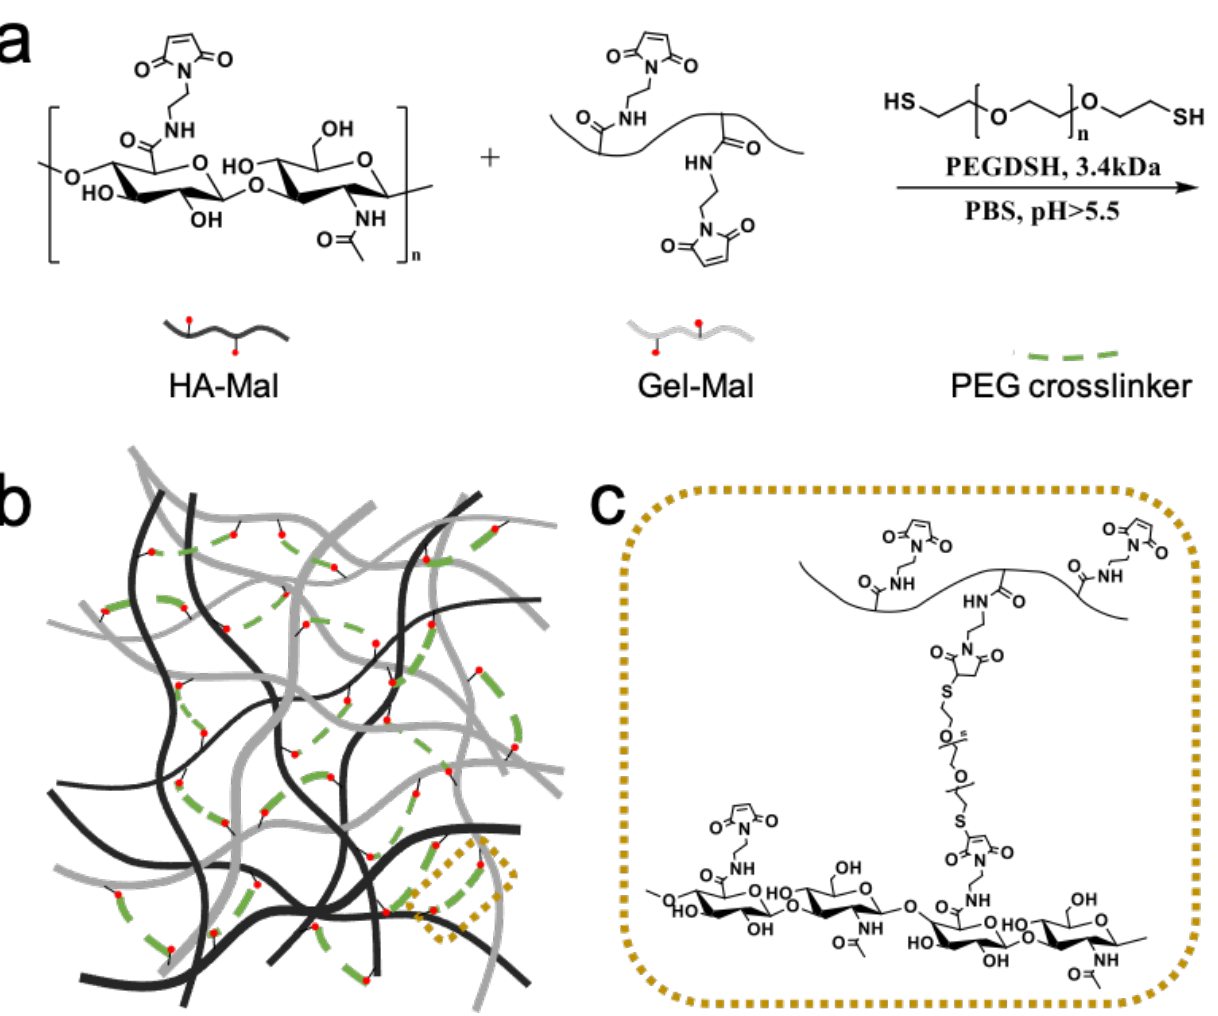
Figure 3. Hydrogel formulation. ( a – c ) Schematic representation of the rapid hydrogel crosslinking reaction with HA-Mal, Gel-Mal, and PEGDSH in PBS. Maleimide groups (red circle) on both HA (black line) and gelatin (gray line) undergo Michael addition reactions with thiols on the PEG crosslinker (dotted green line), resulting in a crosslinked macromolecular network (dotted gold outline).